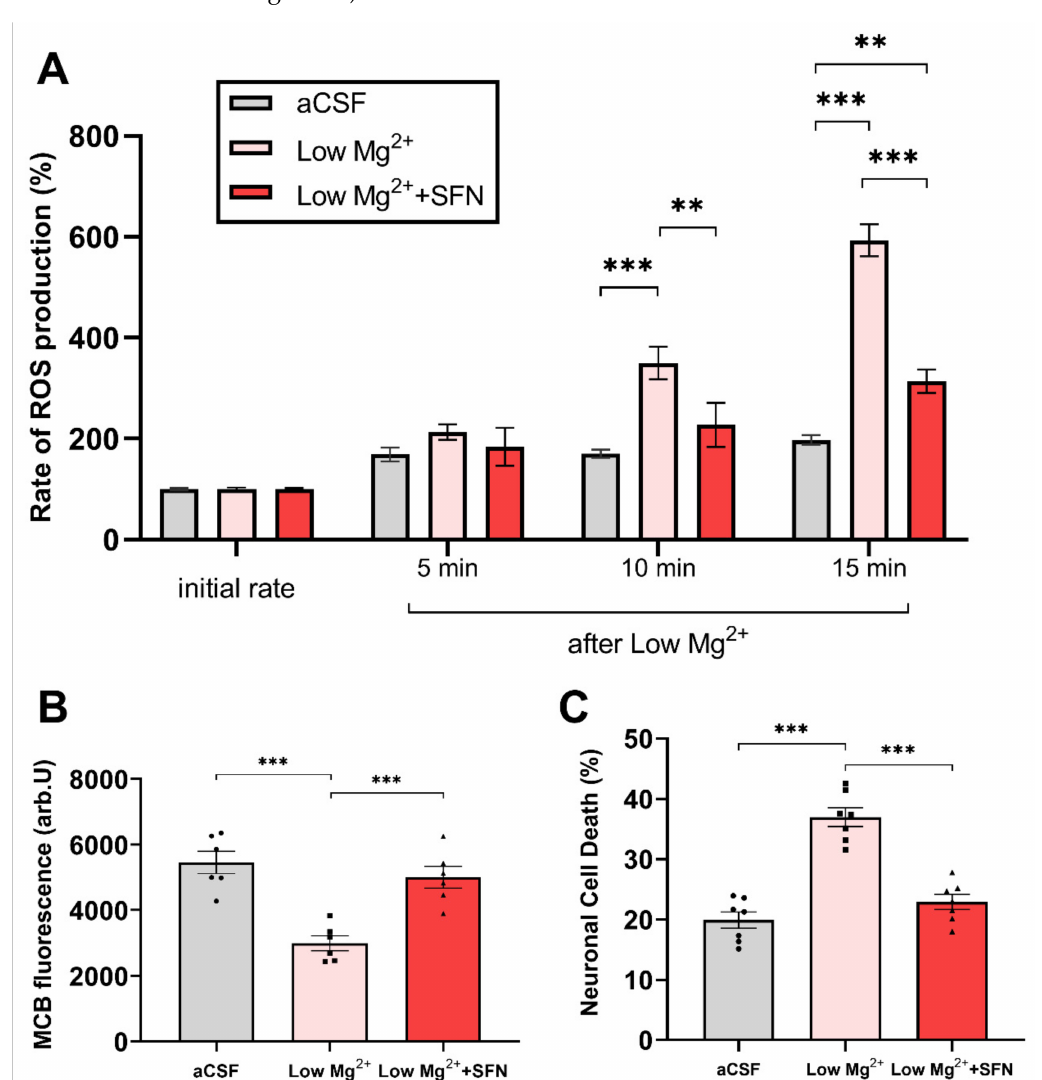
Figure 1. SFN decreases the rate of ROS production, increases levels of glutathione, and decreases epileptiform activity- induced neuronal death. ( A ). Bar chart summarizing the rates of ROS production (mean ± SEM) at 5, 10, and 15 min of neuronal cultures in artificial CSF (aCSF; n = 322 cells, six experiments), after the omission of Mg 2+ from the extracellular solution (low Mg 2+ ; n = 346 cells, six experiments), and cultures treated with SFN (5 µ M, pre-treatment 24 hr) in low-Mg 2+ condition ( n = 358 cells, six experiments). Data were analysed by repeated measures one-way ANOVA [F (2, 12) = 46.63, p < 0.001, followed by Tukey’s multiple comparisons post hoc test. ** p < 0.01, *** p < 0.001 relative to the low-Mg 2+ condition. ( B , C ). Levels of glutathione measured using MCB fluorescence ( B ), n = 6 experiments in all three conditions) and percentage of dead neurons ( C ), n = 7 experiments in all three conditions) in same conditions as in A: aCSF, low Mg 2+ , and low Mg 2+ with SFN (5 µ M, pre-treatment, 24 h). Data were analysed by one-way ANOVA ( B ): F (2, 15) = 18.62, p < 0.001; ( C ): F (2,18) = 43.21, p < 0.001] followed by Tukey’s multiple comparisons test. Data are expressed as the mean ± SEM. ** p <0.01 and *** p <0.001, relative to the low-Mg 2+